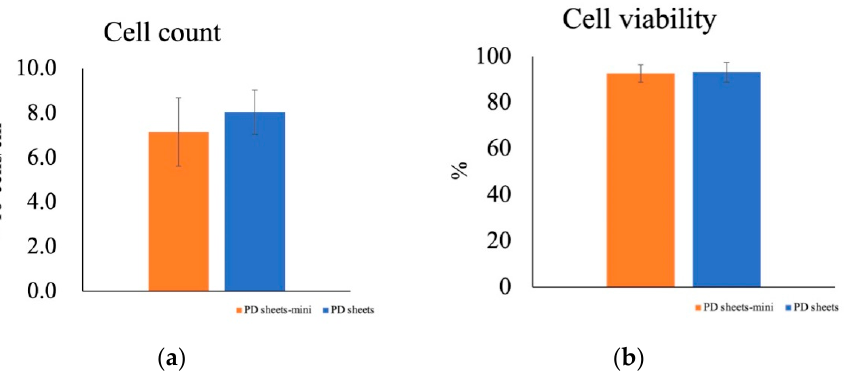
Figure 2. Comparison of cell count and cell viability for PD sheets and mini PD sheets. Values are expressed as mean ± standard deviation. ( a ) Cell count of PD sheets and mini PD sheets. ( b ) Cell viability of PD sheets and mini PD sheets. The cell counts and cell viability did not differ between the two types of cell sheets.